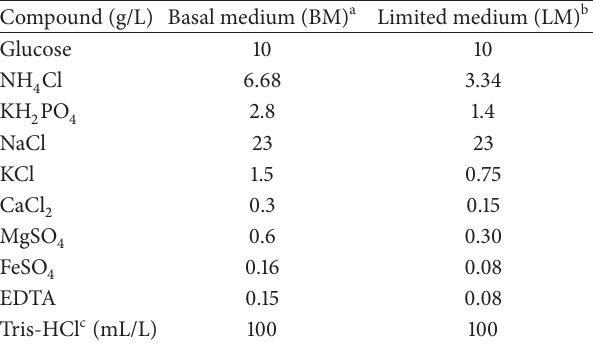
Table 1: Chemical composition of the culture mediums used: basal medium (BM) and nutrients limited medium (NL).